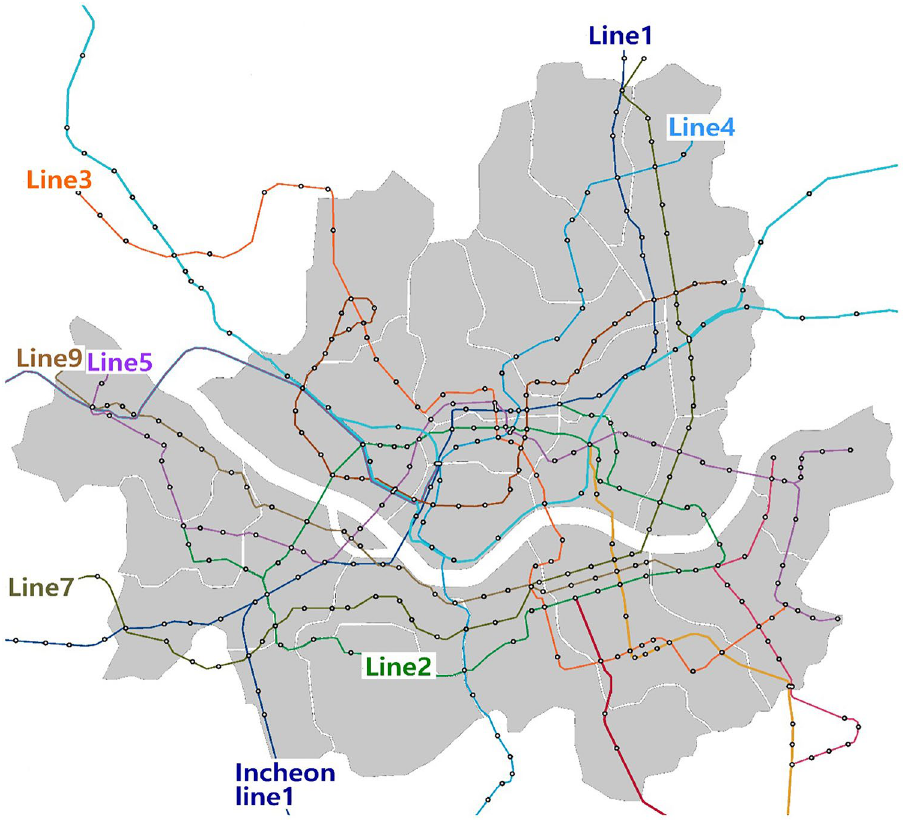
Figure 1. Location of subway lines 1, 2, 3, 4, 5, 7, and 9, and Incheon line 1 in Seoul and Incheon, South